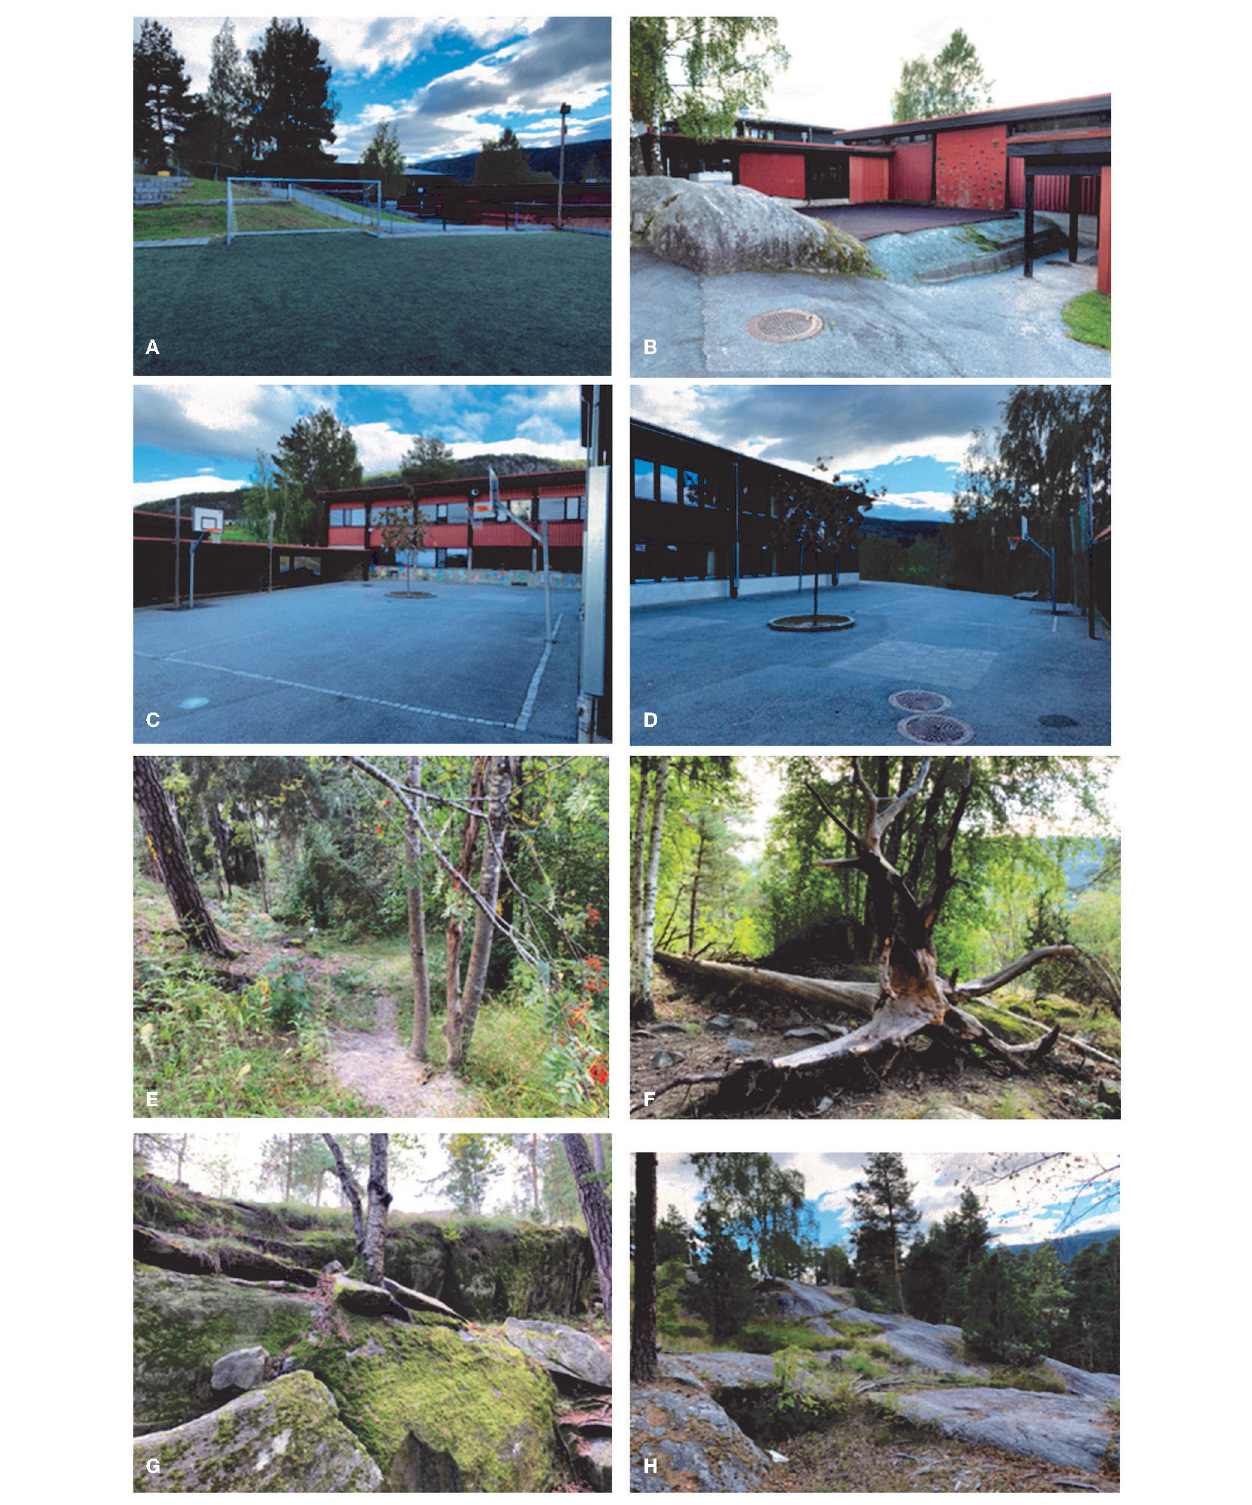
FIGURE 2 | School ground environments showing potential affordances for different activities: The constructed schoolyard environments: (A) the multifunctional ballgame court, (B) the climbing wall with a soft cover substrate, (C) the basketball court, (D) the volleyball/ball game court. Environmental affordances of the natural forest: (E) cross-country running and hide-and-seek; (F) jungle gym, climbing, and balancing; (G) climbing and bouldering; (H) cross-country running (high speed).